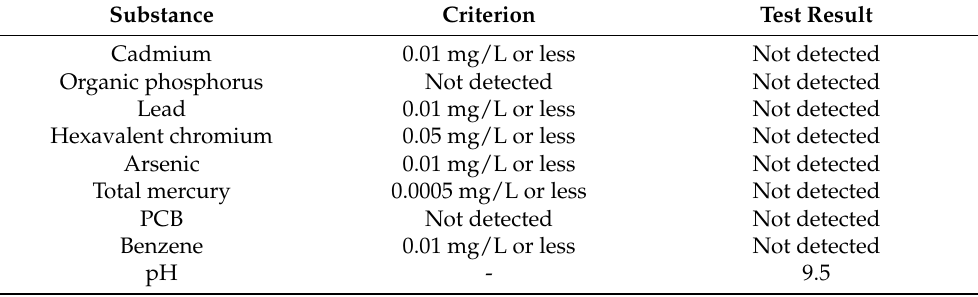
Table 10. Leaching test